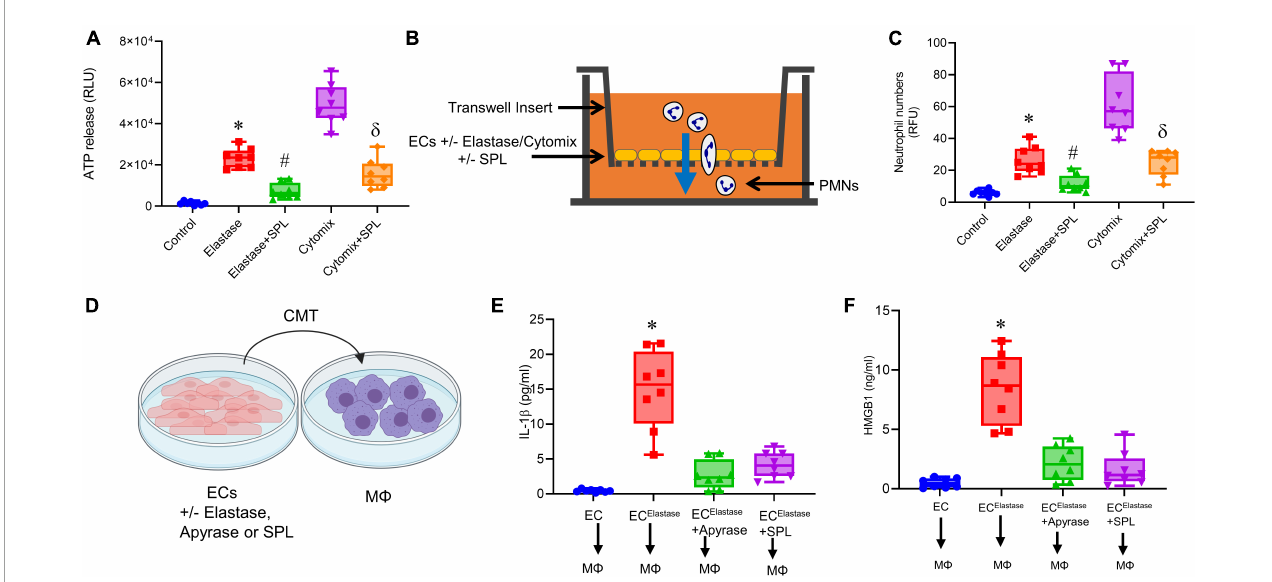
FIGURE7 Spironolactone decreases EC-mediated eATP release to mitigate macrophage activation. (A) eATP release by ECs after transient elastase-exposure or cytomix-treatment is attenuated by SPL compared to untreated controls. ∗ P < 0.0001 vs. control; # P < 0.0001 vs. elastase; δ P < 0.001 vs. cytomix; n = 8/group. (B) Schematic of fluorescent-labeled polymorphonuclear neutrophils (PMNs) trafficking through ECs using a transwell assay. (C) SPL treatment of ECs significantly decreased neutrophil transmigration after transient elastase- or cytomix-treatment. ∗ P = 0.002 vs. control; # P = 0.04 vs. elastase; δ P < 0.0001 vs. cytomix; n = 8/group. (D) Conditioned media transfer (CMT) from elastase-treated ECs to macrophages with/without SPL or apyrase pre-treatment. (E,F) SPL treatment of ECs inhibited upregulation of IL-1 β and HMGB1 secretion by macrophages after CMT from ECs. ∗ P < 0.0001 vs. all other groups; n =